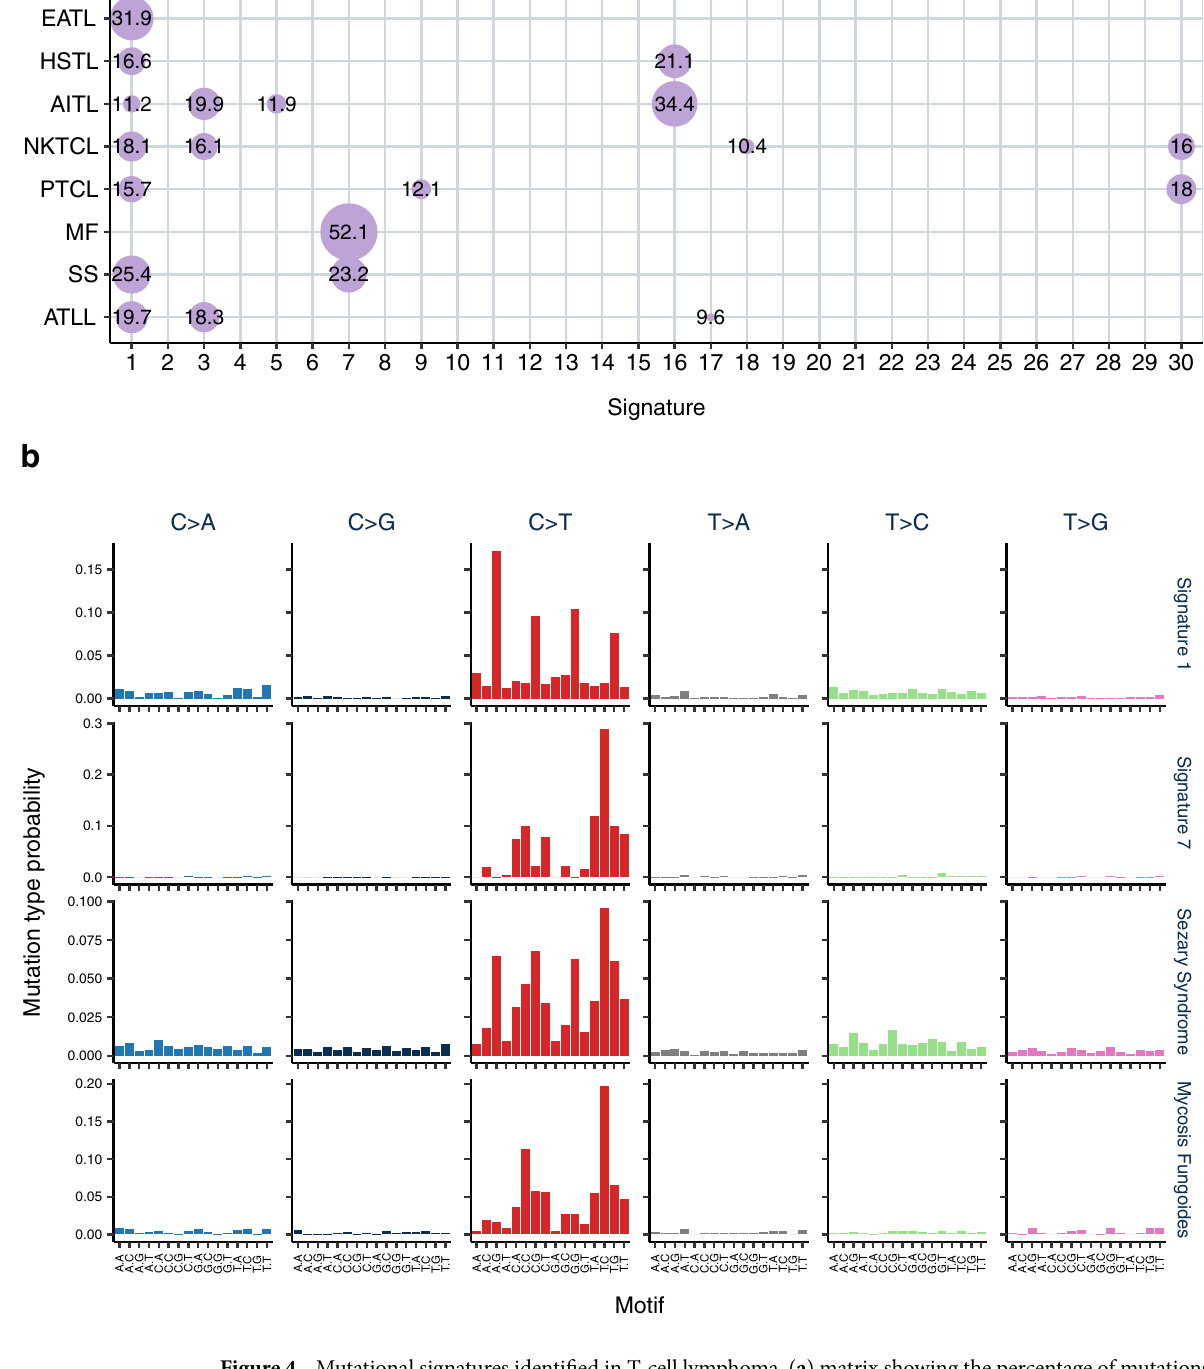
Figure 4. Mutational signatures identified in T-cell lymphoma. ( a ) matrix showing the percentage of mutations in each disease subtype assigned to the 30 COSMIC signatures. ( b ) plots showing the likelihood of each mutation in each trinucleotide context for Signatures 1 and 7 as per COSMIC mutational signatures v2 and the observed SNV catalogues for Sezary syndrome and mycosis